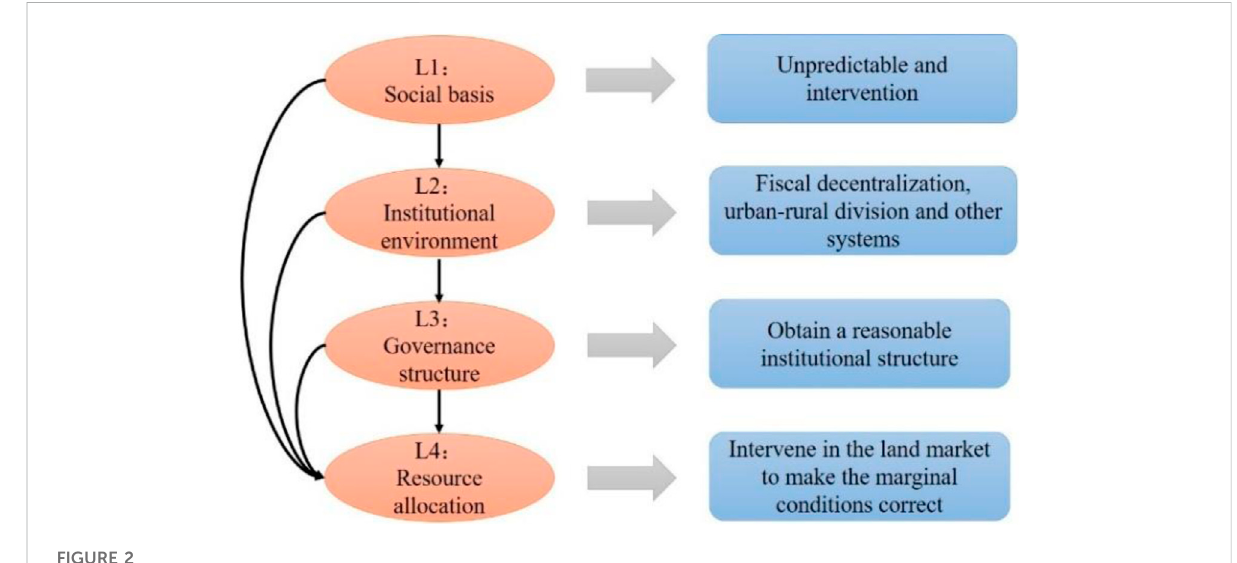
FIGURE 2 Four-level institutional analysis of Williamson ’ s framework.